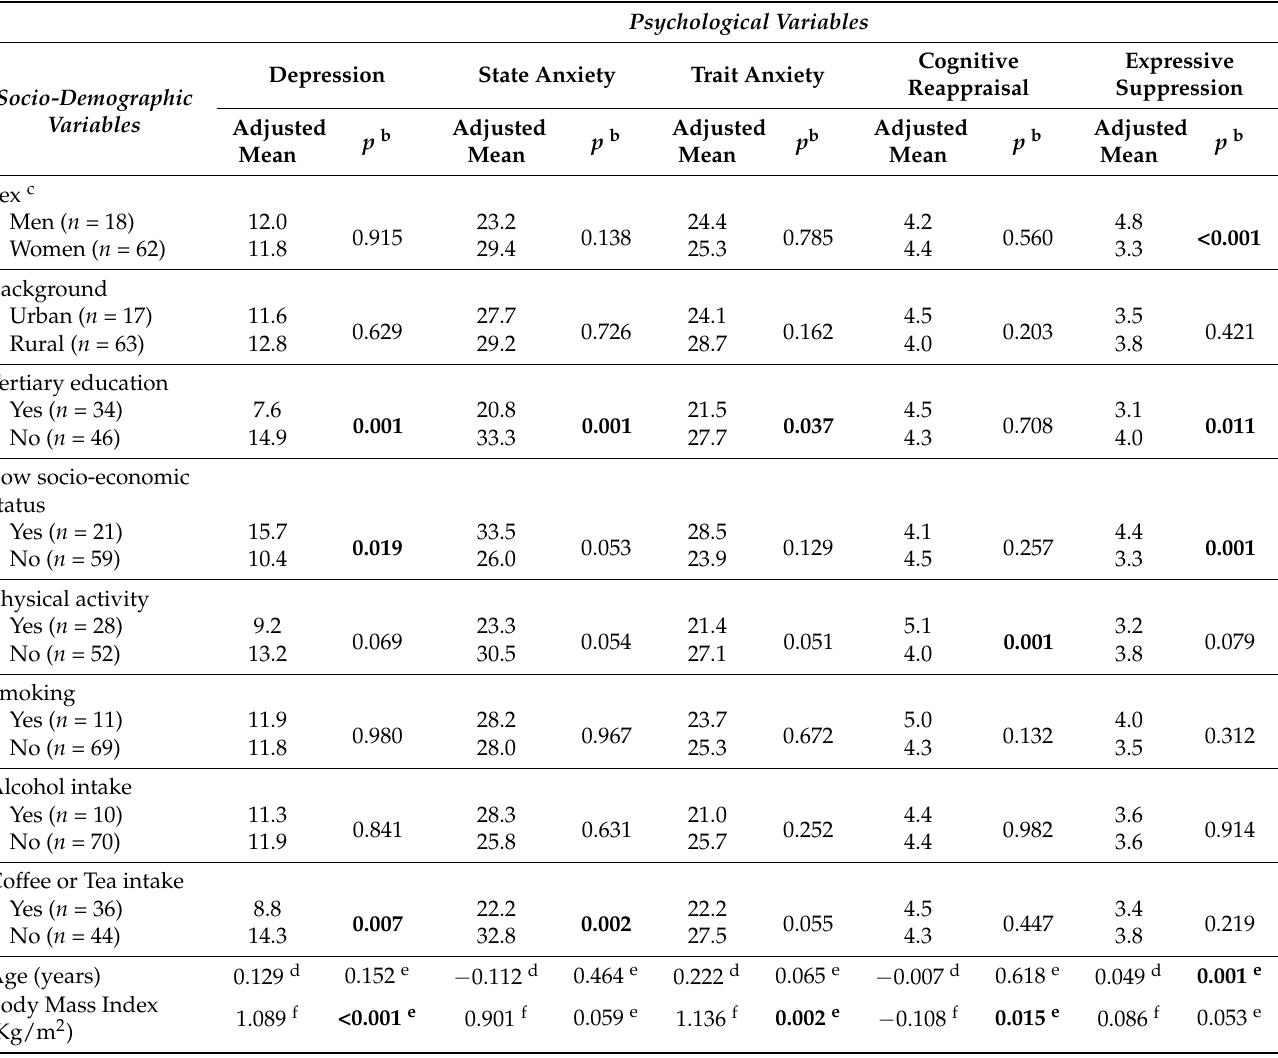
Figure 1. Presence of anxiety ( a ) and level of depression ( b ). CTTH: chronic tension-type headache. HC: healthy control. Table 2. Adjusted a scores for Depression, State and Trait Anxiety, Cognitive Reappraisal and Expressive Suppression by socio-demographic